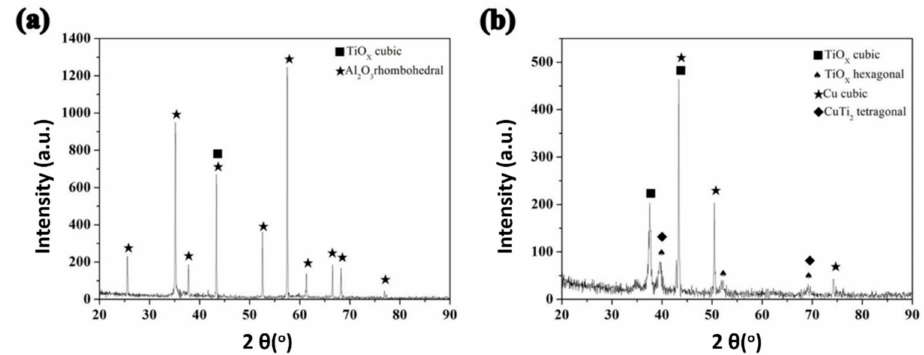
Figure 2. XRD analysis of Ti–0.5 La thin films deposited on ( a ) alumina and ( b ) copper